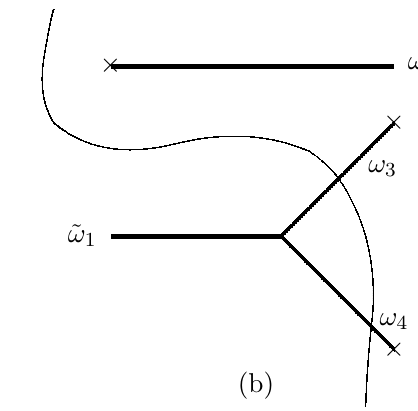
Figure 6 . The figure on the left shows a Feynman diagram of open closed string field theory, describing part of the contribution to the product of an annulus one point function and a disk one point function. A × denotes the one point closed string interaction vertex associated with one point function on the disk and a free end marks an external state. All energies flow from the left to the right. The figure on the right is a cut of this diagram, with the thin curve denoting the cut, drawn such that all the D-instanton type interaction vertices are to the right of the cut. The corresponding Feynman diagrams in the closed string effective field theory are obtained by collapsing all the × ’s into a single composite vertex. These have been shown in figure